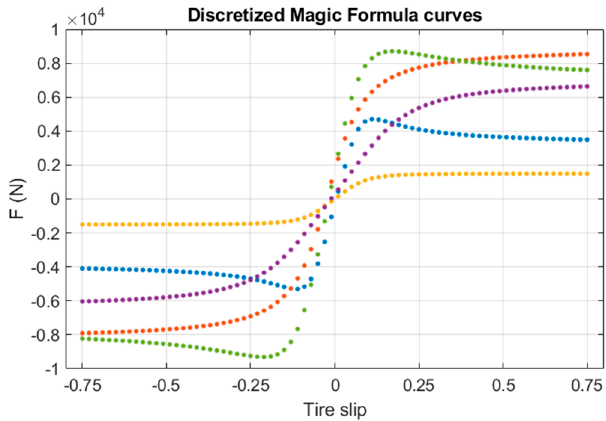
Figure 4. Discretization of MF curves.